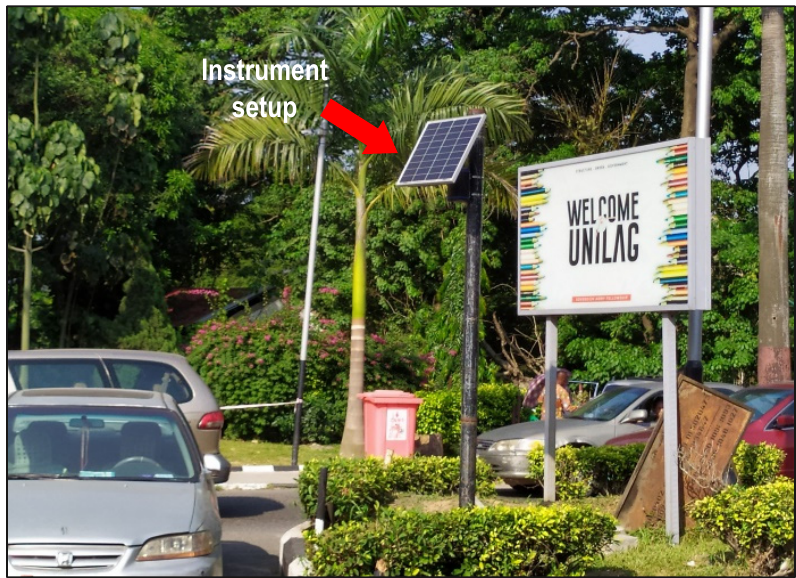
Figure 3. Measurement site at the university main gate house (© SQUARES Project).